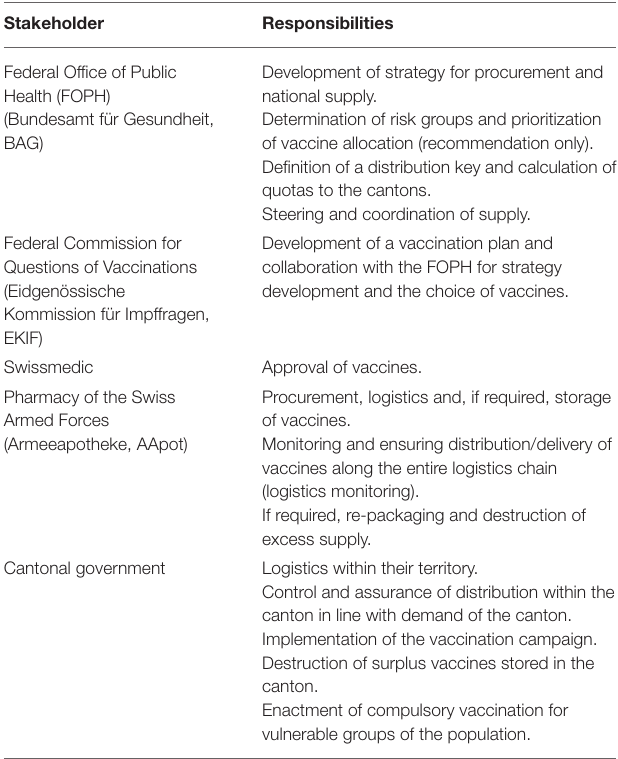
TABLE 1 | Stakeholders and responsibilities in a pandemic, based on BAG (15,